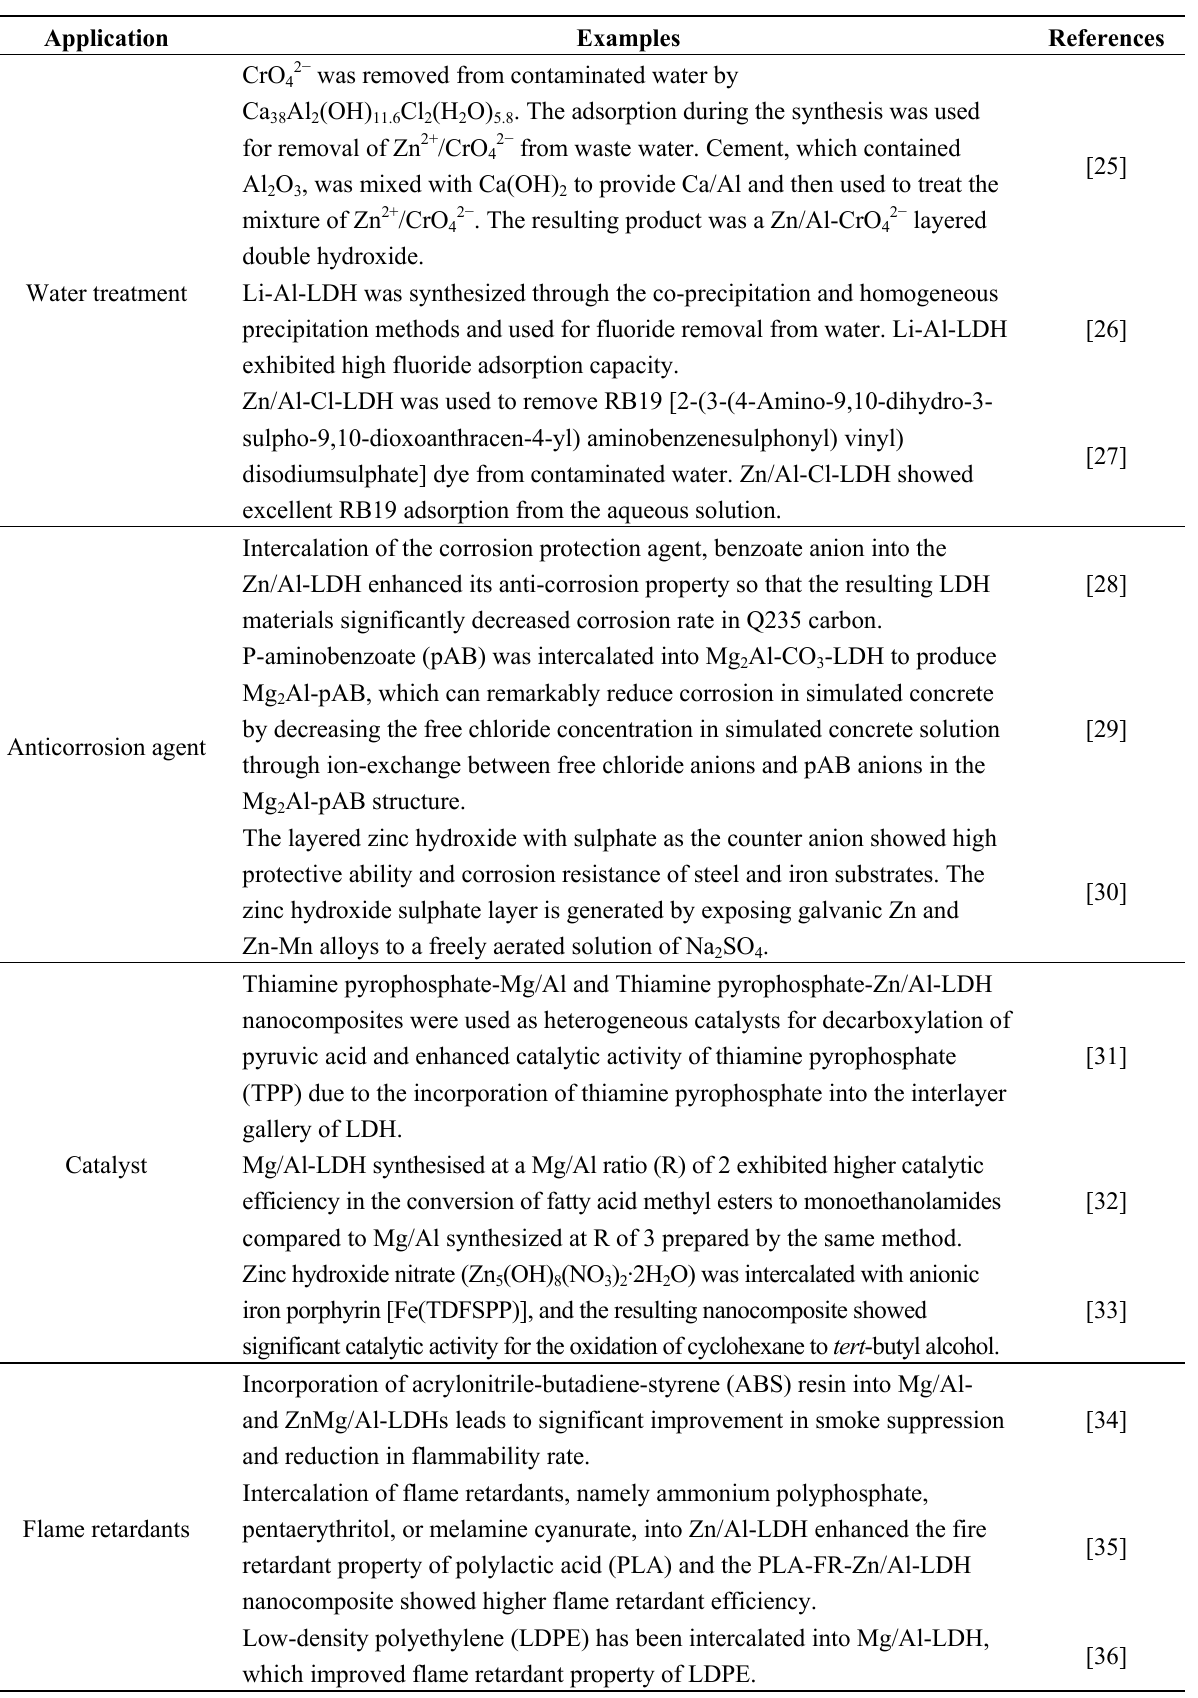
Table 1. Various applications of